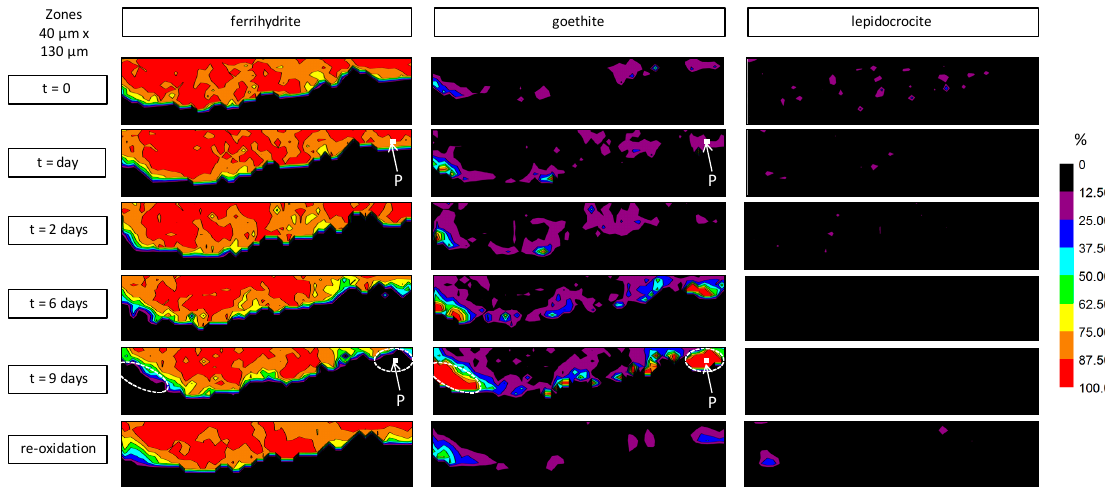
Figure 7. Quantitative µRS maps in the zone identified by the dot line on Figure 2b: before the test ( t = 0), after 1, 2, 6, and 9 days of deaerated water circulation, and after re-exposure to ambient air during one day (re-oxidation). The regions circled by a dot line correspond to those where ferrihydrite has disappeared after nine days of deaerated water exposure. The spectra corresponding to point P, for one and nine days, are presented in Figure 8.